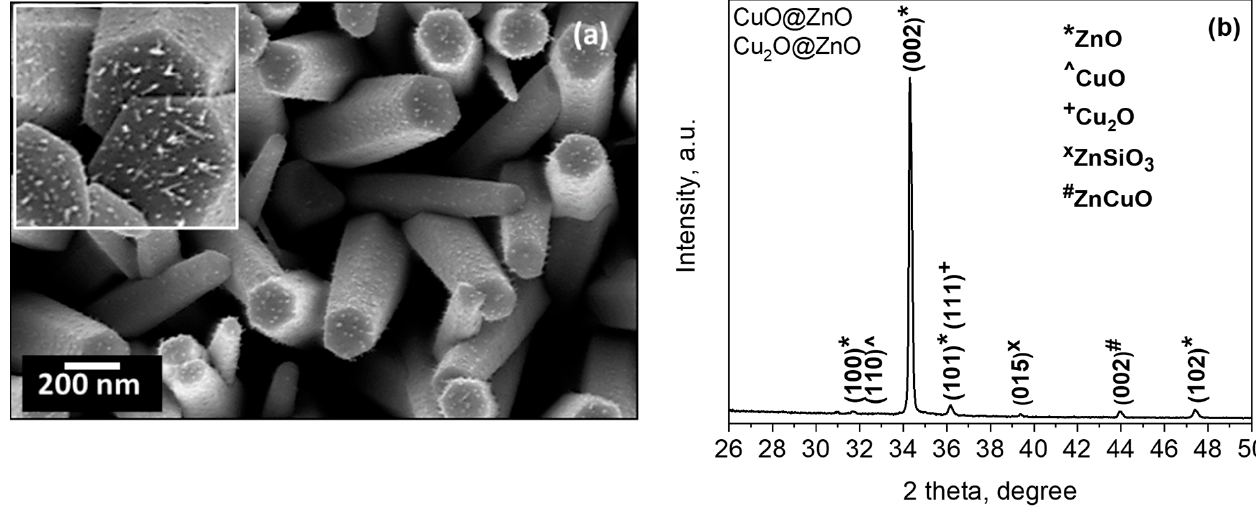
Figure 7. ( a ) SEM images (the inset shows a magnified image of the Cu decorated ZnO rods) and ( b ) XRD diffraction pattern of the copper-modified zinc oxide structured films.